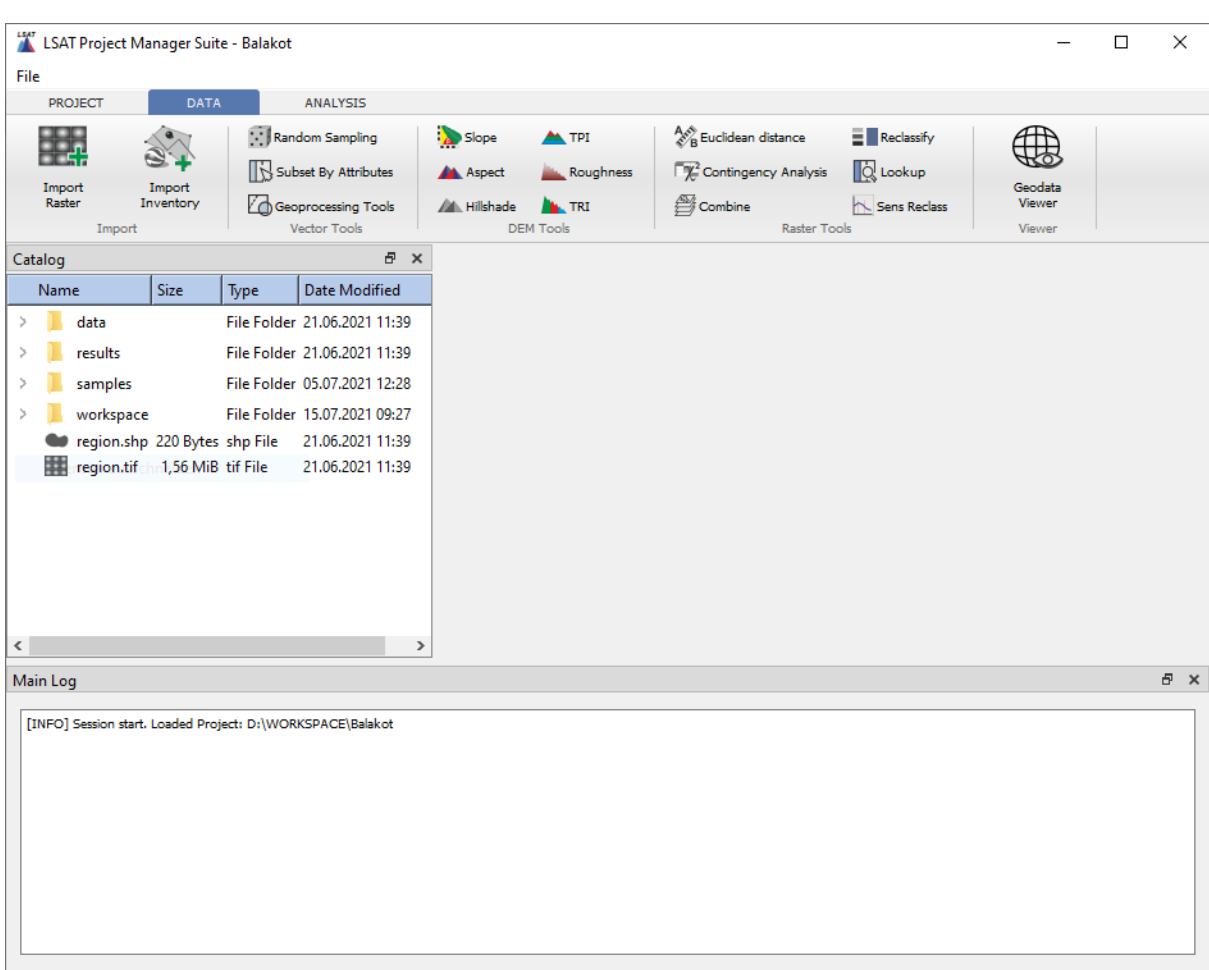
Figure 2. Main GUI with activated Data tab. The Data tab contains tools for data import, vector data processing, DEM tools, tools for raster processing, and a simple data